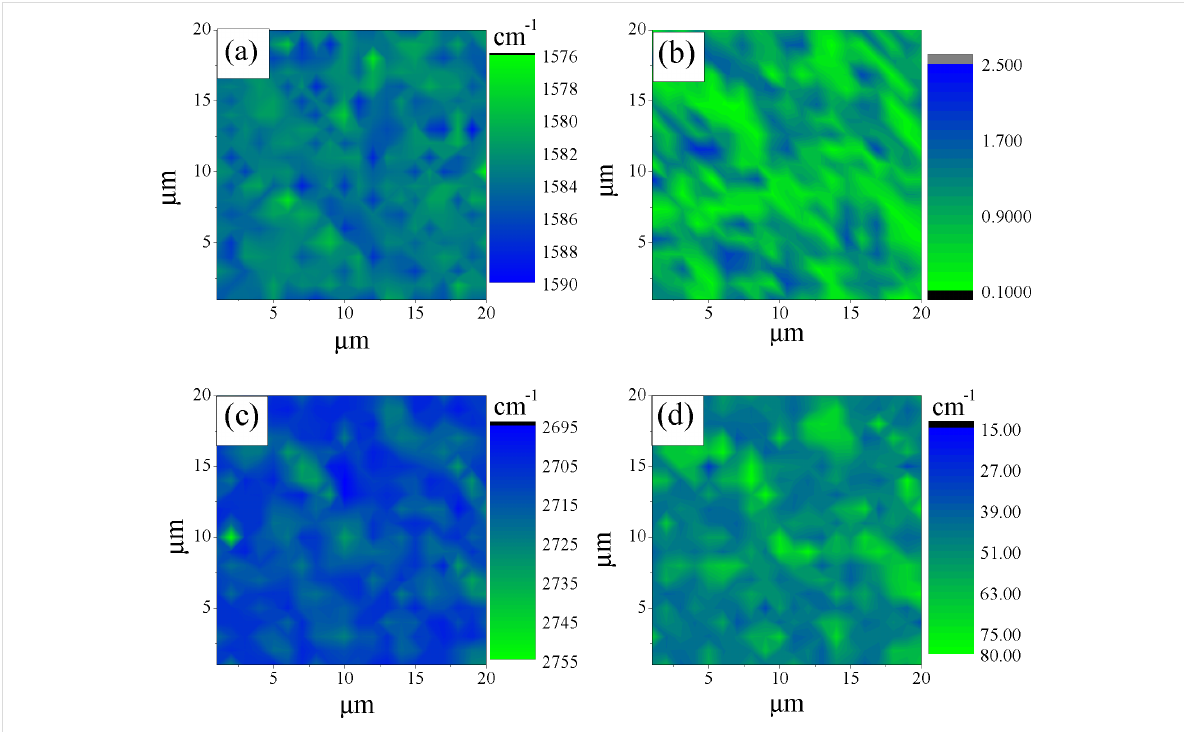
Figure 5: Raman maps of sample B on a SiO 2 /Si substrate acquired at a laser excitation wavelength of 473 nm. (a) G band position. (b) I 2D / I G ratio. (c) FWHM of the 2D band. (d) 2D band position.